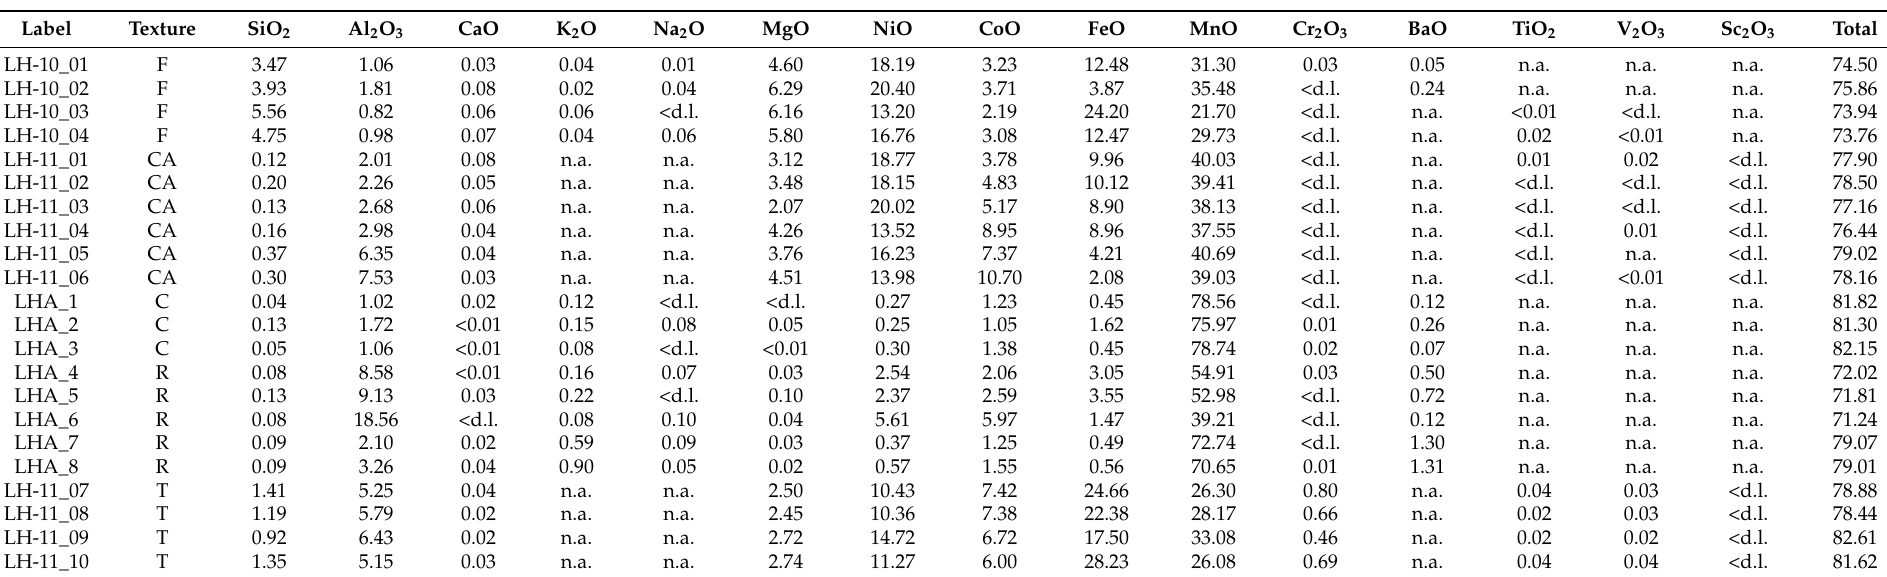
Table 2. Representative EMP analyses (in weight percent) of the studied Co–Mn-oxyhydroxide types in Loma de Hierro (Venezuela). <d.l.: below detection limit; F-fibres; CA–colloform aggregates; C-core; R-rim;